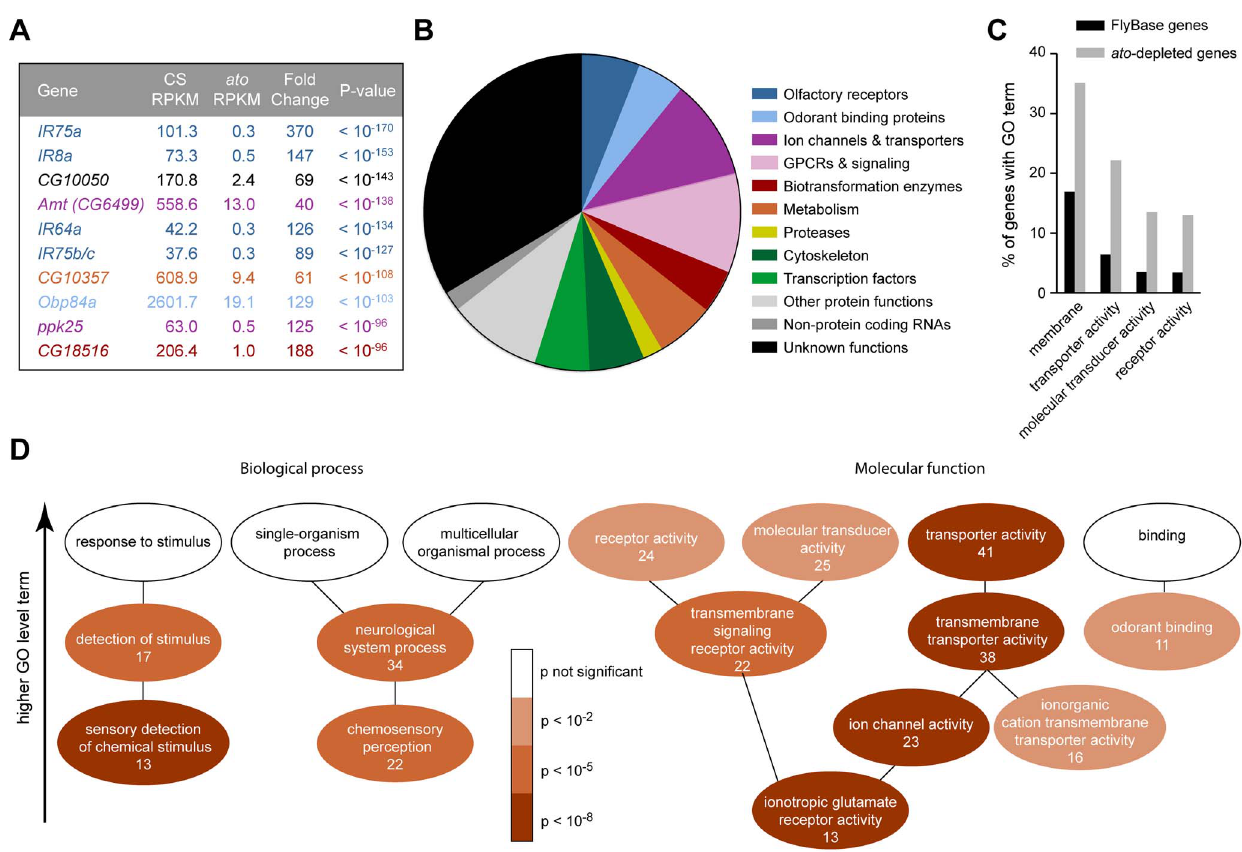
Figure 3. Functional categorization of 250 genes depleted in ato. (A) The ten genes that show the most signification depletion in ato , based on p-value. Each is color-coded according to the categories in panel (B). (B) Categorization of the 250 genes that show at least four-fold reduction in ato with a FDR , 0.01. Putative functions were determined by examination of automated gene annotation and BLAST searches to identify similar proteins. (C) Gene Ontology (GO) term analysis using the program AmiGO identified four level two terms that were significantly enriched among the 250 ato -depleted genes compared to all D. melanogaster genes listed in FlyBase. See Figure S7 for the complete analysis of all level two GO terms. (D) Significance of enrichment of lower level terms, which form a subset of higher level terms ( e.g. ‘‘detection of stimulus’’ is a subset of ‘‘response to stimulus’’). Lower level terms were selected to illustrate the types of functions most enriched in the dataset. The number of ato -depleted genes annotated with each GO term is indicated. We note that the ion channel genes depleted in ato include two members of the ppk family, ppk25 and ppk10 , two members of the Trp family, nanchung and inactive , and four potassium channel genes: shaw-like (shawl), TWIK-related acid-sensitive K + channel (Task7), Inwardly rectifying potassium channel 1 (Irk1) , and CG1756 . Depleted genes described by ‘‘transmembrane signaling receptor activity’’ included six GPCRs: 5-HT2, 5-HT7, CG43795, frizzled 3 (fz3), Pigment-dispersing factor receptor (Pdfr), and CG18208 .